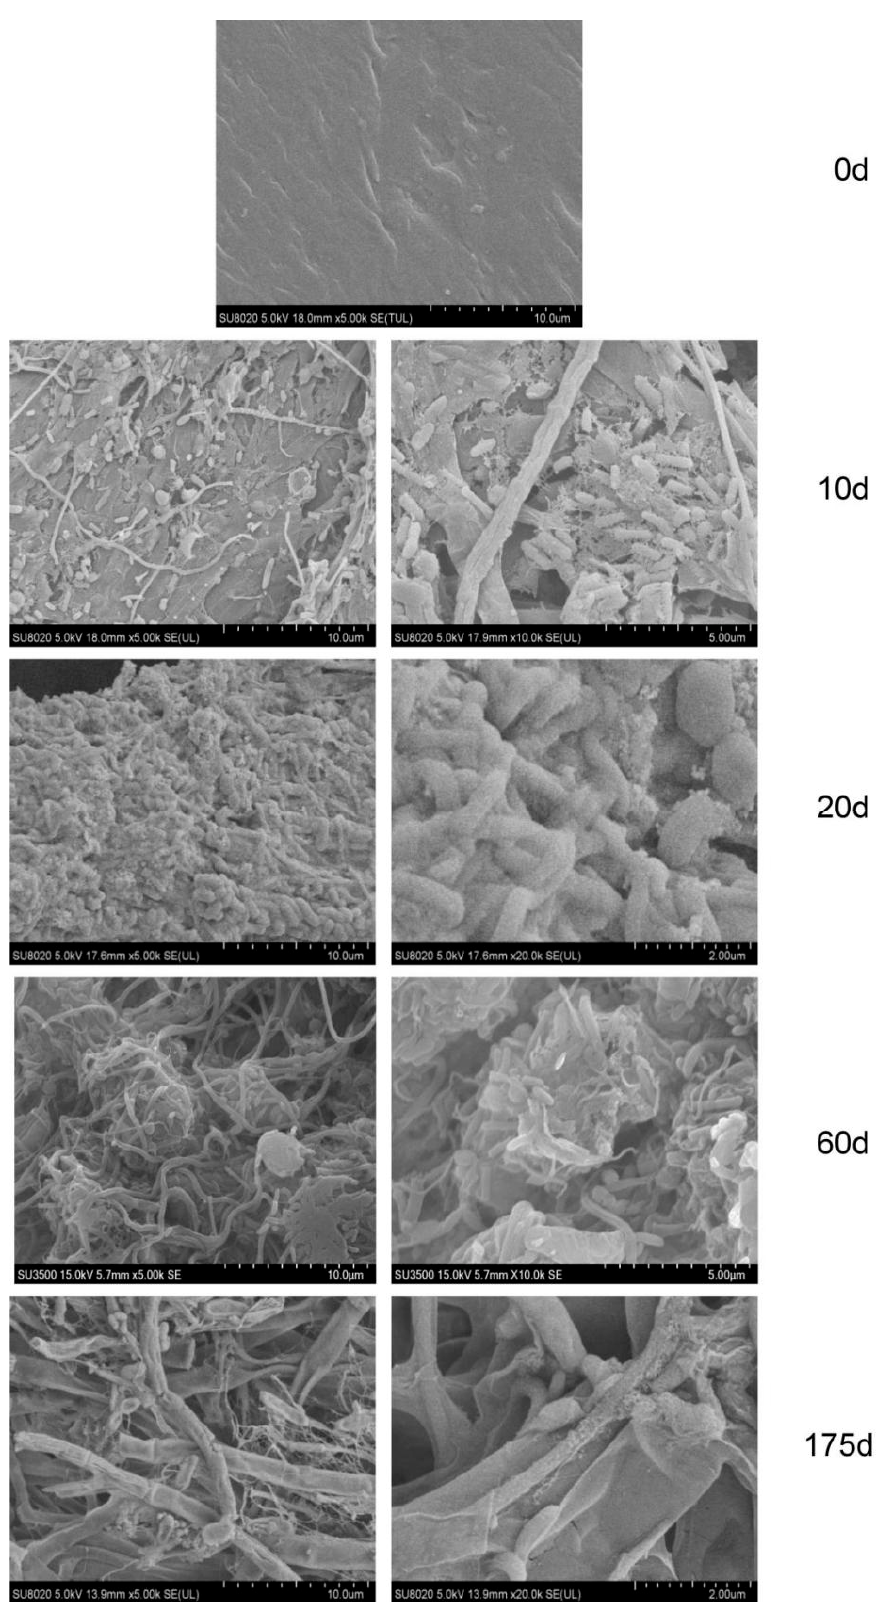
Figure 3. Scanning electron micrographs of bio fi lm sludge in the WRBC system.